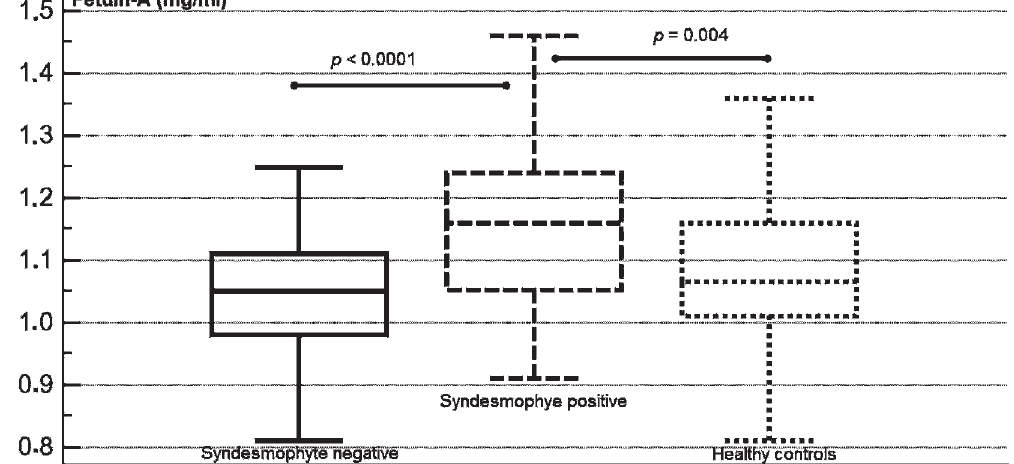
Figure 1 - Box plot of the mean fetuin-A levels for two groups of patients (with and without syndesmophytes) and healthy